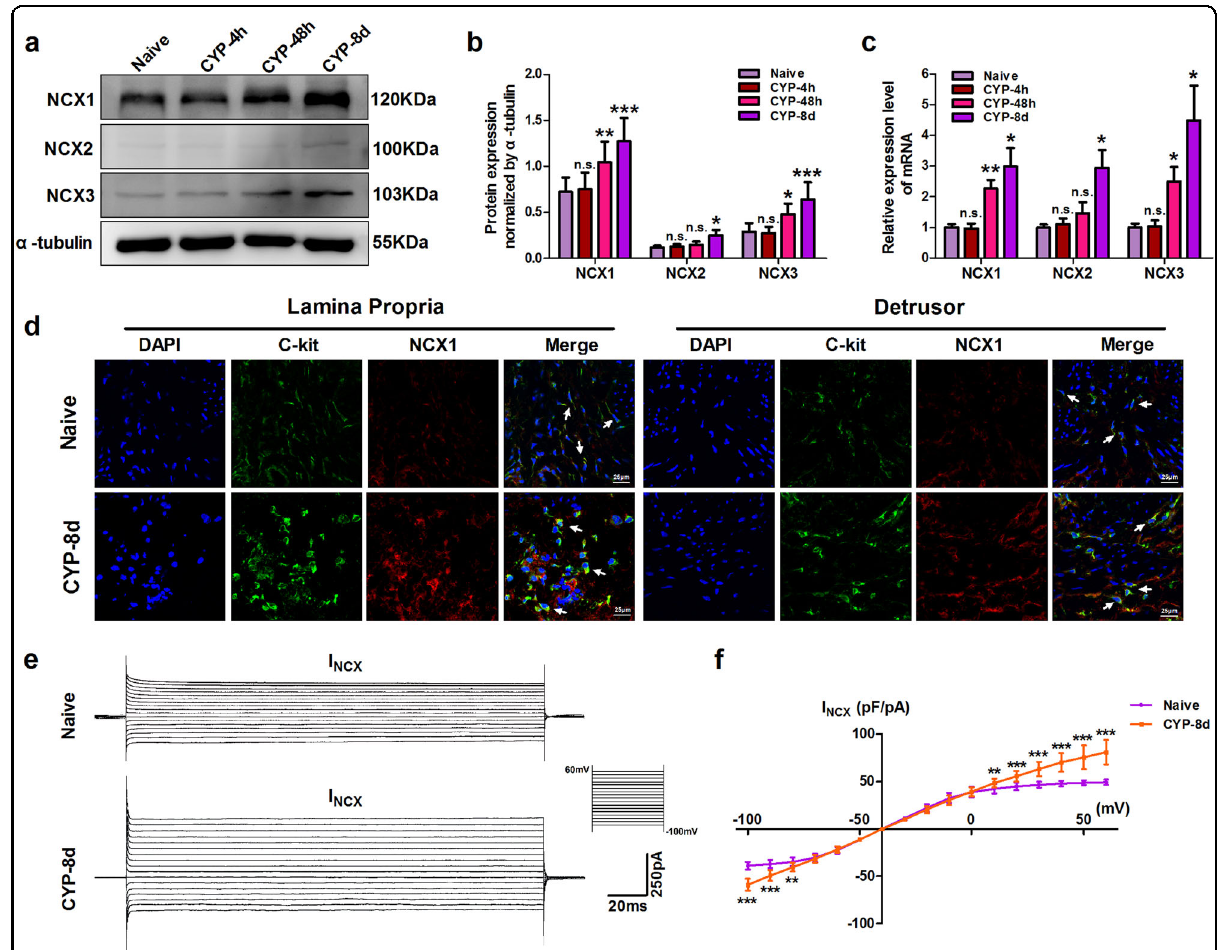
Fig. 5 Na + /Ca 2 + exchanger (NCX) expression levels were signi fi cantly increased and the reverse mode of NCX was relatively activated in bladder ICC-LCs from CYP-8d rats. a – c The mRNA and protein expression levels of NCX1 and NCX3 were signi fi cantly increased in CYP-48h and CYP-8d rat bladders compared with those in naive and CYP-4h rat bladders, and increases in CYP-8d rat bladders were more signi fi cant; the mRNA and protein expression levels of NCX2 were only increased in CYP-8d rat bladders. d Changes in NCX1 expression (red) in bladder c-kit (green)- positive ICC-LCs (white arrows) were detected using IF staining. Bladder ICC-LCs from CYP-8d rats possessed higher NCX1 protein expression than those from naive rats. e , f NCX current (I NCX ) in isolated bladder ICC-LCs from naive and CYP-8d rats was evoked by a step potential ranging from − 100 to + 60 mV in increments of 10 mV for 200 ms, with a holding potential of − 40 mV. The forward and reverse modes of NCX were elicited over a voltage range of − 100 to − 50 mV and − 30 to + 60 mV, respectively, and are exhibited as the bottom and upper part of the characteristic I NCX traces. When normalized to cell capacitance, the absolute value of the I NCX density in bladder ICC-LCs from CYP-8d rats signi fi cantly exceeded that in bladder ICC-LCs from naive rats over a voltage range of − 100 to − 80 mV (forward mode) and + 10 to + 60 mV (reverse mode). Notably, the increase in the reverse mode of NCX was more signi fi cant (the data represent the mean ± S.D., n = 8; * P < 0.05, ** P < 0.01, and *** P < 0.001, versus naive